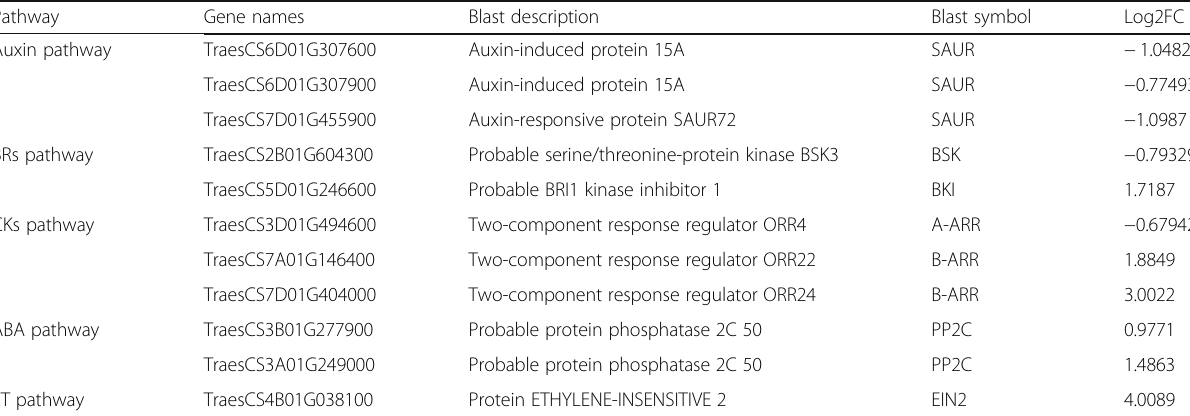
Table 2 List of differentially expressed genes related to phytohormones